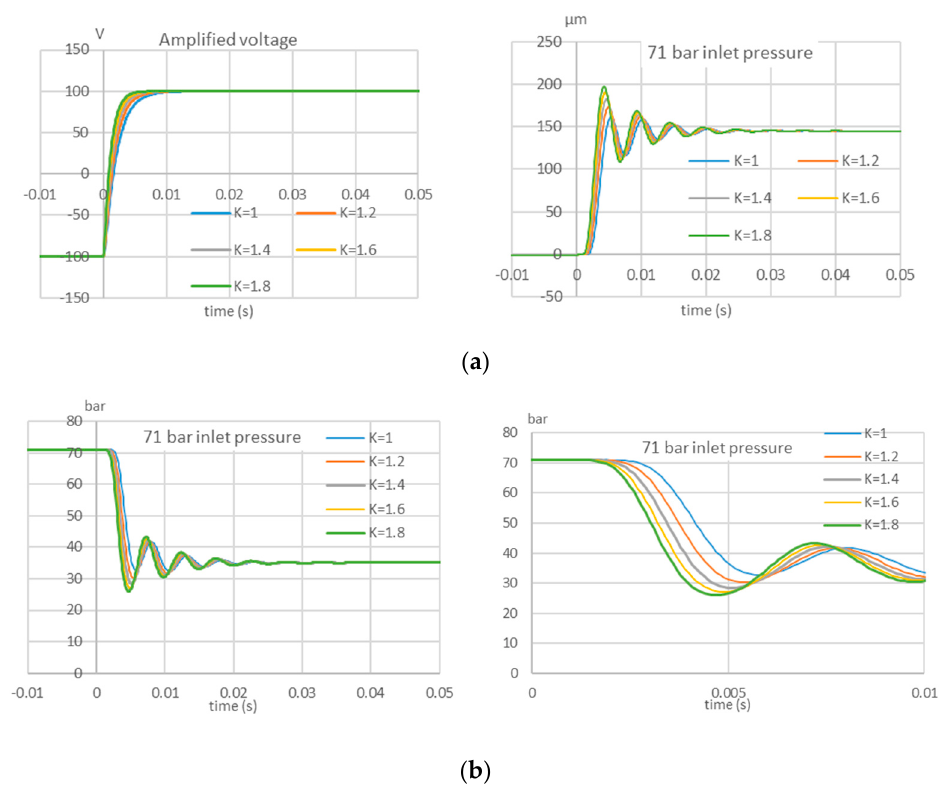
Figure 15. Amplified voltage and ring bender displacement ( a ) and pressure at point 7 with enlargement ( b ), simulated for an amplified voltage from − 100 V to + 100 V and for di ff erent values of the natural frequency of the amplifier: ω n = k ω n , o with K = 1, 1.2, 1.4, 1.6, 1.8 (supply pressure = 71 bar, D = 0.6 D 0 and L = 0.6 L 0 , m = 0.6 m 0